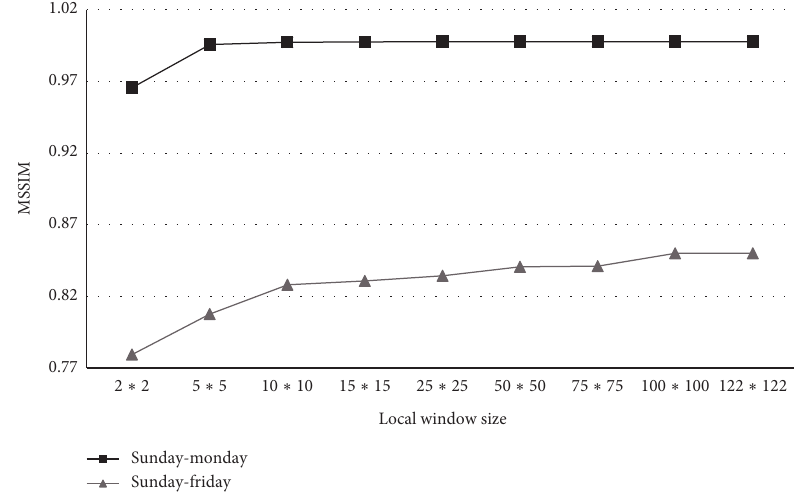
Figure 10: Comparison of MSSIM results considering variation in the dimensions of local windows.